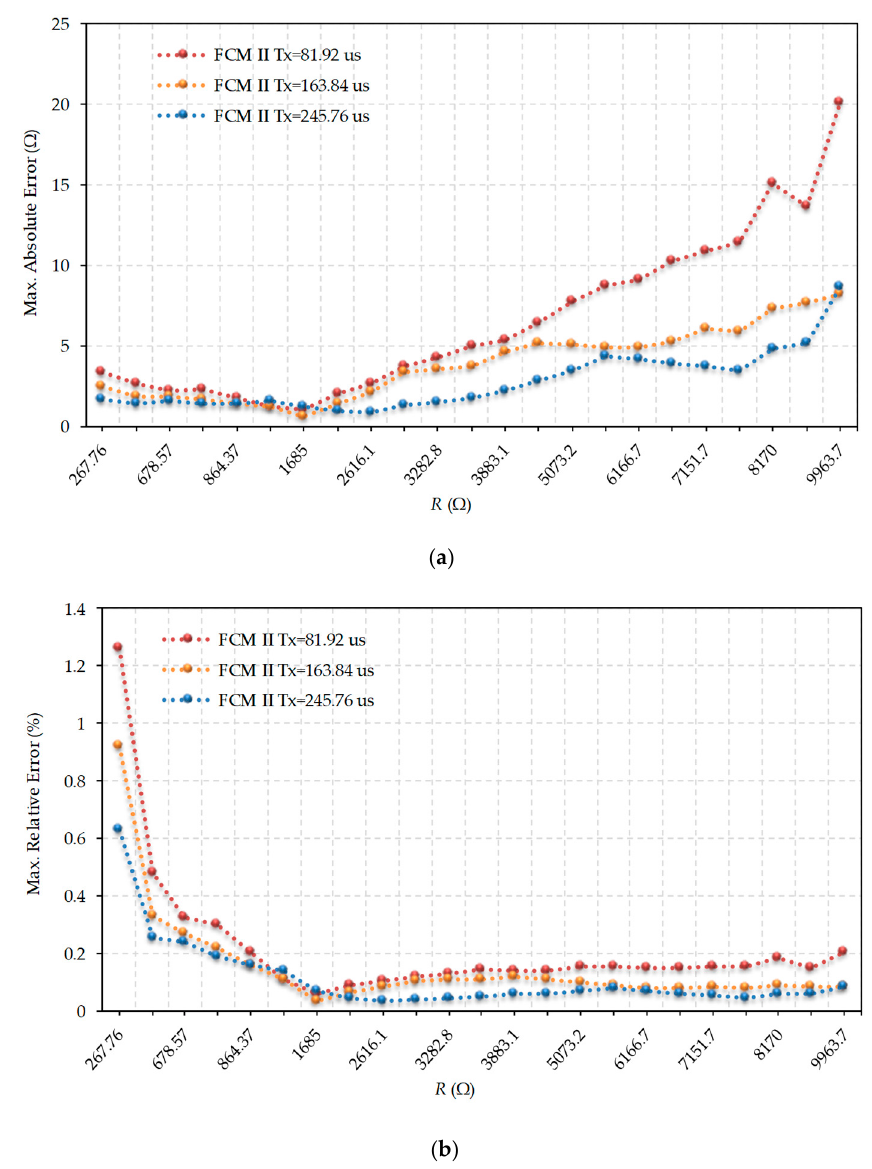
Figure 7. Maximum errors in the evaluation of R for different values of T x in Fast Calibration Method II (FCM II). ( a ) Maximum absolute error, ( b ) Maximum relative error.